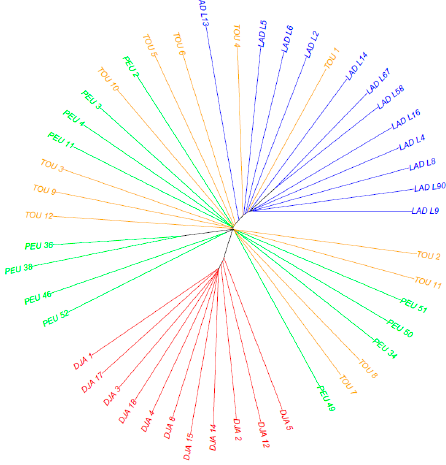
Figure 3. Neighbour-joining tree relating the 47 individuals of the four Senegalese breeds. The tree was constructed using allele sharing distances averaged over 44,321 SNPs. Labels are coloured according to the individual breed of origin.